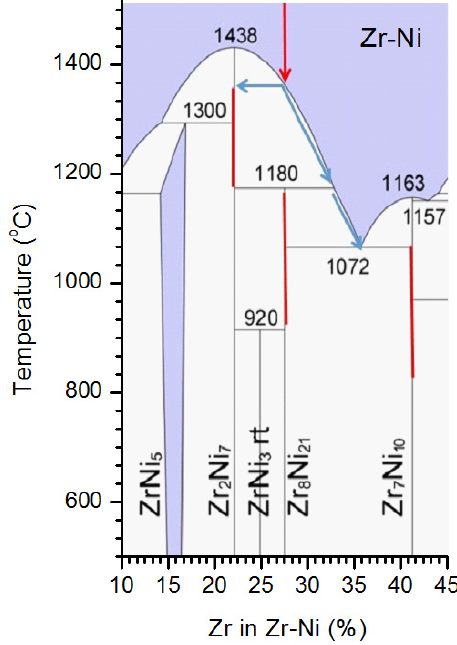
Figure 5. Ni-Zr phase diagram showing formation of the observed phases during continuous cooling of the Zr 8 Ni 21